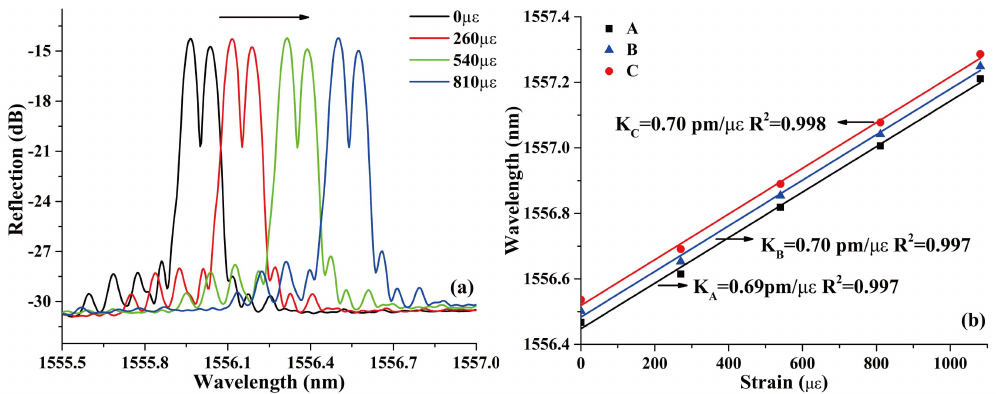
Figure 6. ( a ) Spectral responses of the PS-ECFBG under different strain and ( b ) the corresponding linear fit of peaks A, B, and